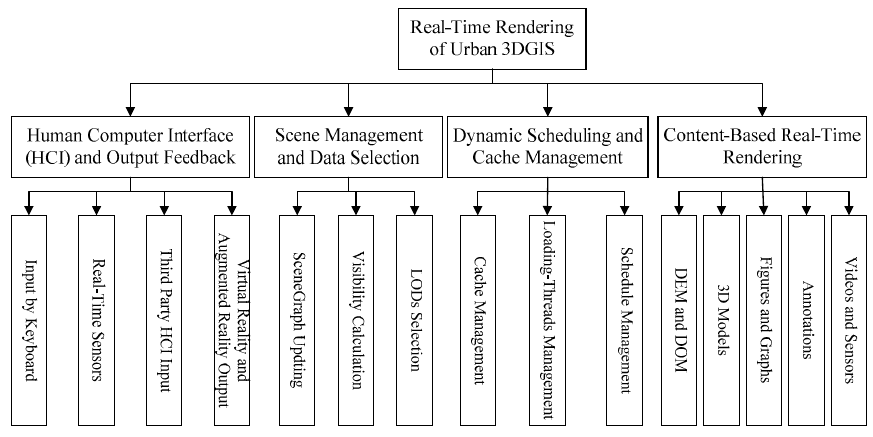
Figure 1. Procedure of real-time visualization of urban 3DGIS (three-dimensional Geographic Information Systems).